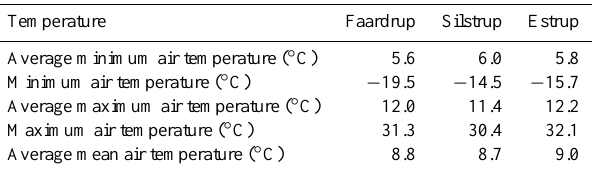
Table 3. Annual average of minimum, mean, and maximum air tem- peratures for 2001–2012 at Faardrup, Silstrup and